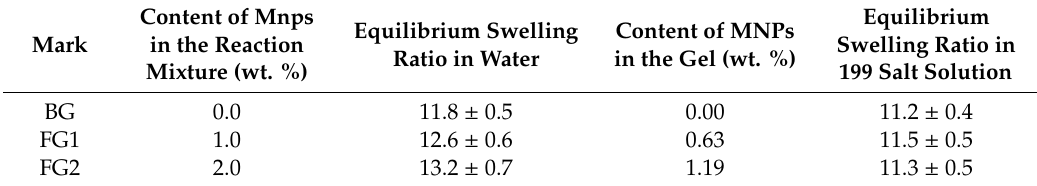
Table 1. Compositions and selected properties of “blank” gel and